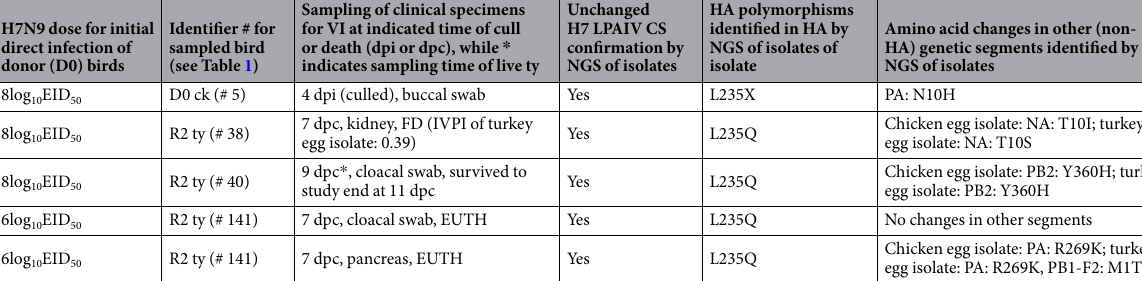
Table 2. Sequencing findings of H7N9 progeny viruses obtained as virus isolates from a directly-infected chicken (D0) and three infected contact turkeys (R2). Full-genome sequences were obtained by NGS of the D0 chicken H7N9 isolate (obtained by VI in chicken eggs), while both chicken and turkey eggs were used to isolate H7N9 from the R2 turkeys. Further evidence for an unchanged LPAIV CS during H7N9 in vivo infection and transmission is summarised in Supplementary Table S3. The broader occurrence of the identified polymorphisms in the PB2, PB1-F2, PA and NA genes was investigated by analysing all available China-origin H7N9 gene sequences (Supplementary Table S4). Species abbreviations: ck = chicken; ty = turkey; FD = found dead; EUTH = euthanised; NGS = Next generation